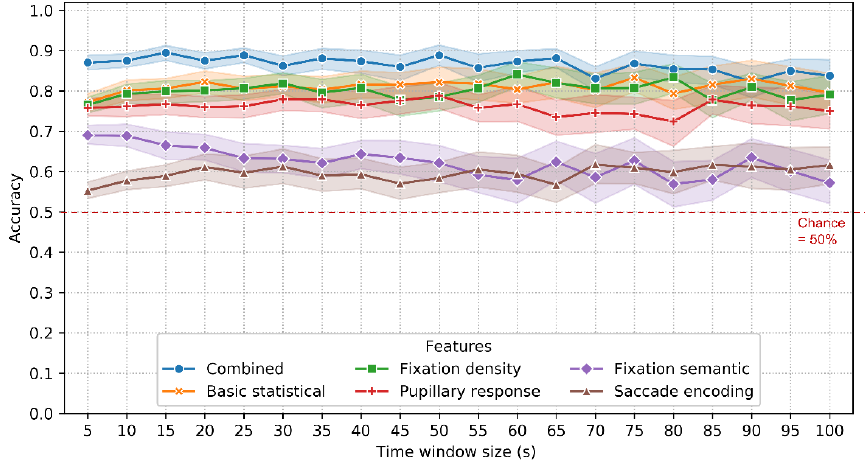
Figure 11. Accuracy and 95% CI with varying time window size and feature types in the verification scenario. Refer to Table A3 in Appendix A for detailed accuracy values.